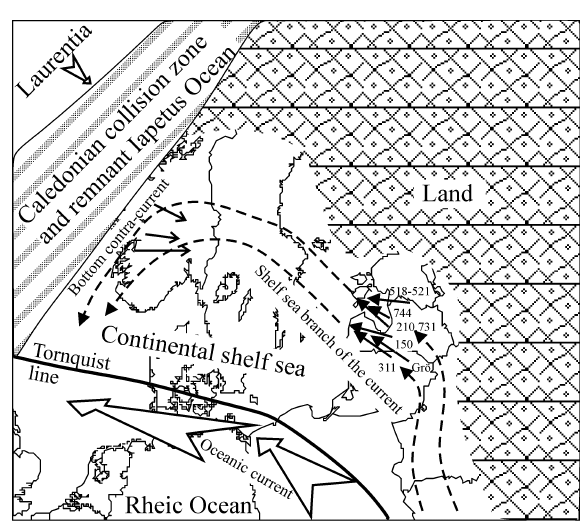
Fig. 6. Silurian shelf sea in Baltoscandia with interpreted shelf sea currents (arrows with broken lines). Arrows with solid lines indicate currents which separate the volcanic ash distribution areas into two parts. The ID numbers of the bentonite are near the arrows. The oceanic current is shown according to Kiipli et al. (2009). Arrows indicating coastal contracurrent direction are from Worsley et al.